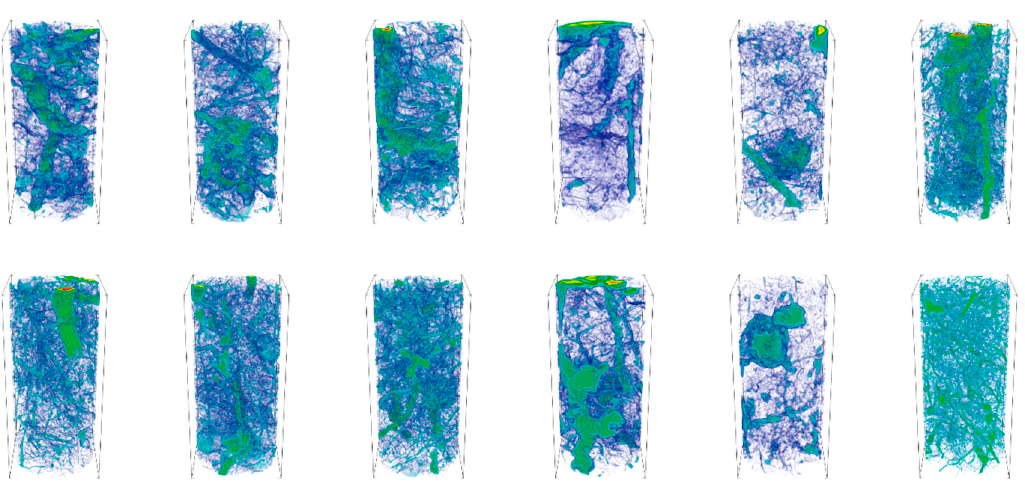
Figure 1. Void visualization of all samples in dry conditions.